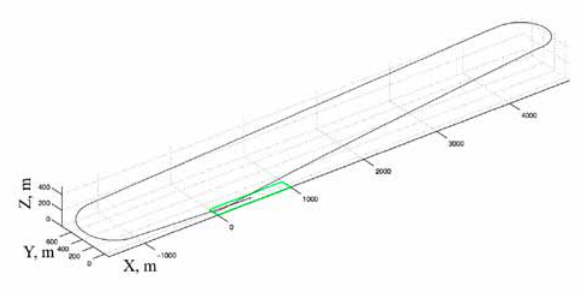
Fig. 13. Double 180° turn manouver